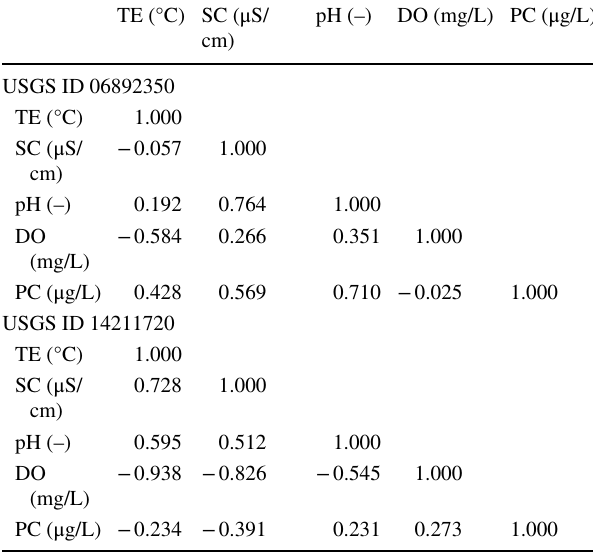
Table 3 Pearson’s correlation coefficients between and among